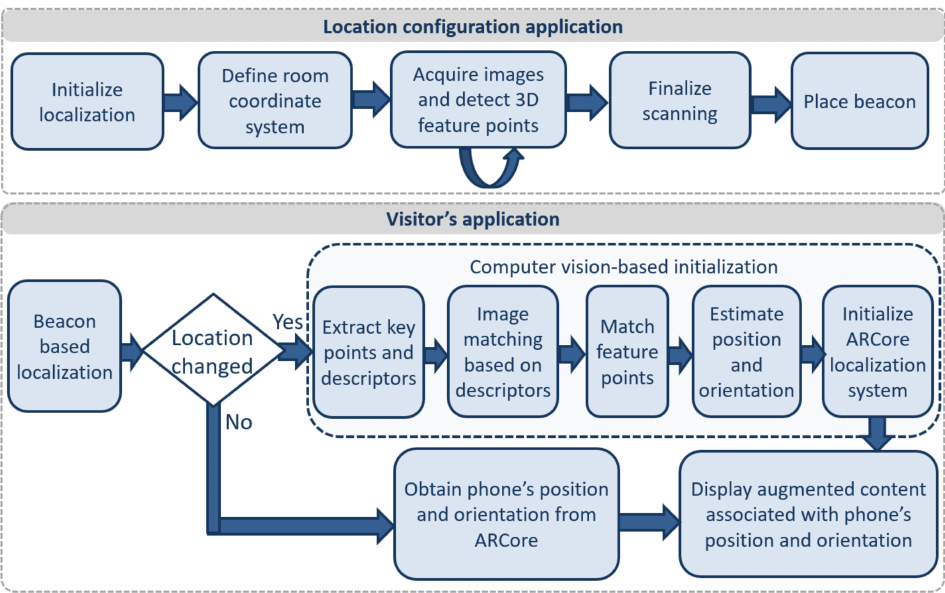
Figure 2. Workflows of the CultReal applications: location manager application ( top ) and visitor application ( bottom